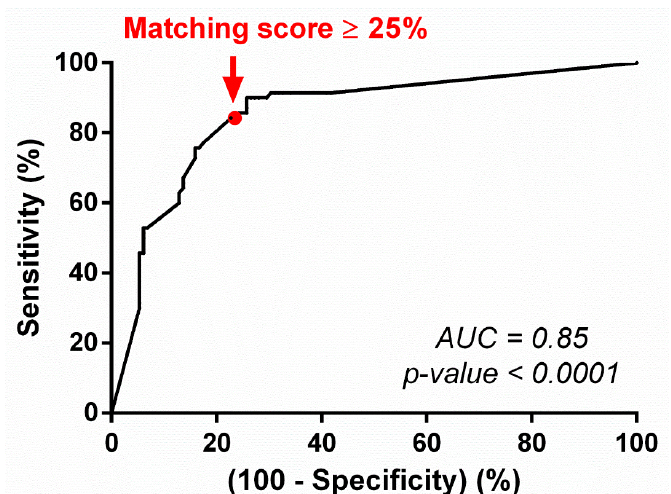
Figure 5. Operating characteristic (ROC) plot of the matching score for the prediction of clinical outcomes. Abbreviations: AUC = area under the curve; ROC = receiver operating characteristic. Table 2. Evaluation of the decision-support platform algorithm performance *.